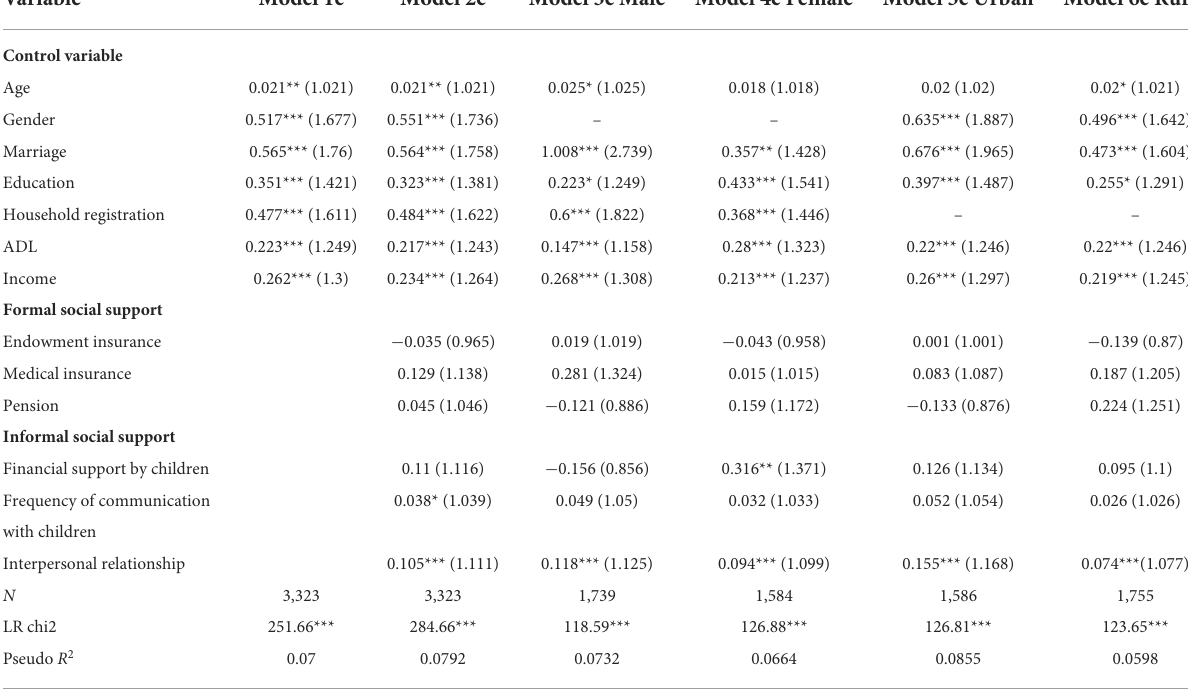
TABLE 4 The impact of formal and informal social support on mental state.